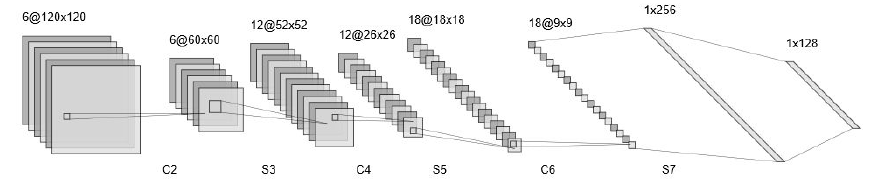
Figure 13. Convolution neural network